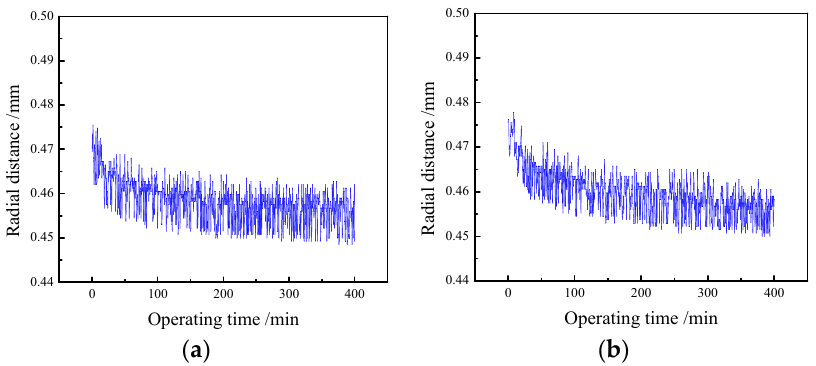
Figure 13. The variation of oil ‐ film thickness from displacement transducer H3 with time at 150 rpm ‐ 6 MPa. ( a ) S220; ( b ) M220.